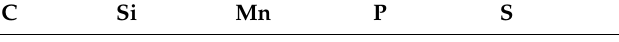
Table 2. Chemical compositions of the specimens (%).